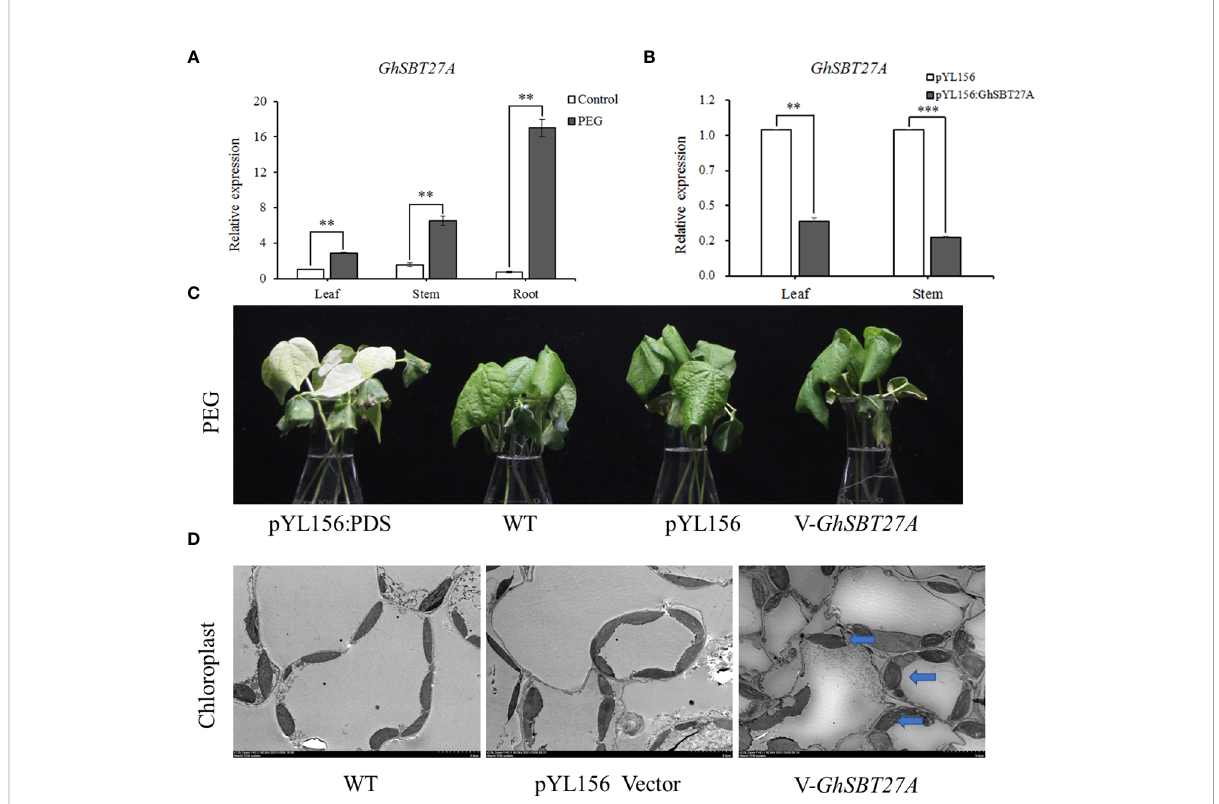
FIGURE 7 Functional veri fi cation of GhSBT . (A) Relative expression of GhSBT27A in different tissues. (B) Detection of GhSBT27A silencing ef fi ciency. (C) Phenotypic comparison of GhSBT27A -silenced plants under PEG stress. (D) Comparison of chloroplast morphology in GhSBT27A -silenced plants under PEG stress as observed by transmission electron microscopy. **and ***represent the differences between the three tissues of cotton roots, stems and leaves at p < 0.01 and p < 0.001 respectively.